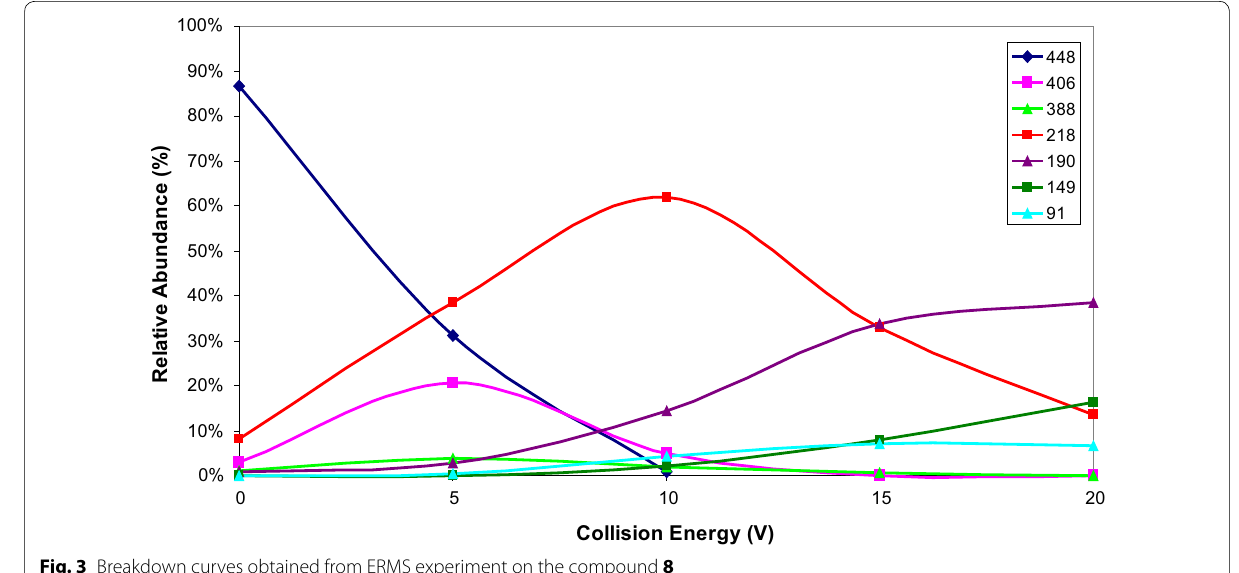
Fig. 3 Breakdown curves obtained from ERMS experiment on the compound 8